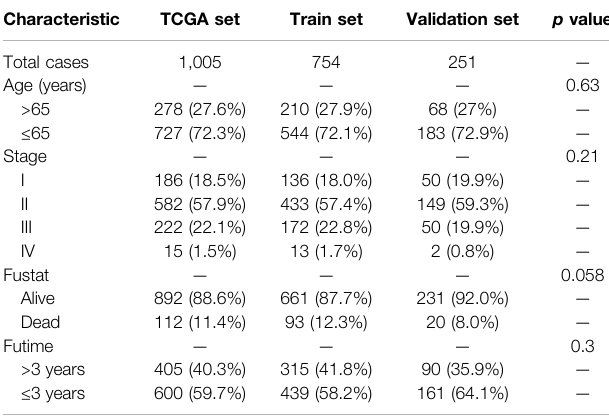
TABLE 1 | Clinicopathological features of the training set and the validation